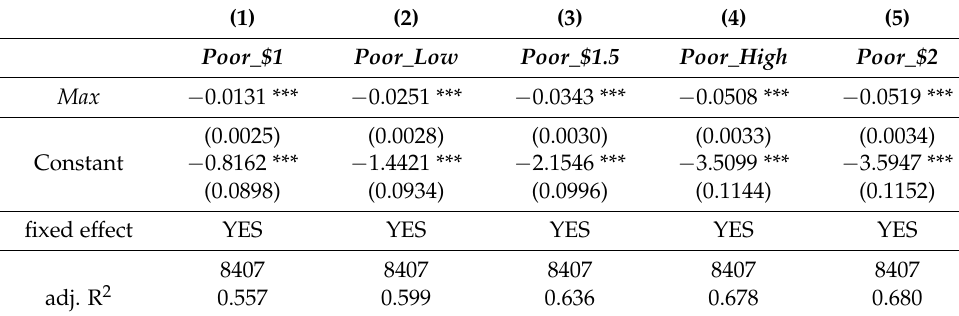
Table 4. Impact of extreme heat on poverty vulnerability.